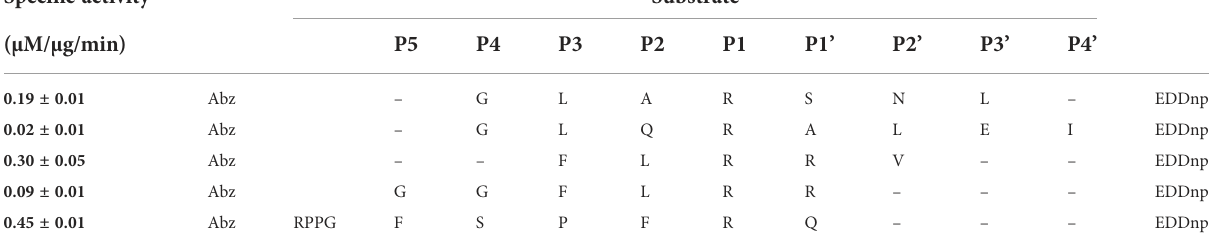
TABLE 2 Speci fi c activities and cleavage points produced by L. interrogans leptolysin on FRET substrates. Speci fi c activity